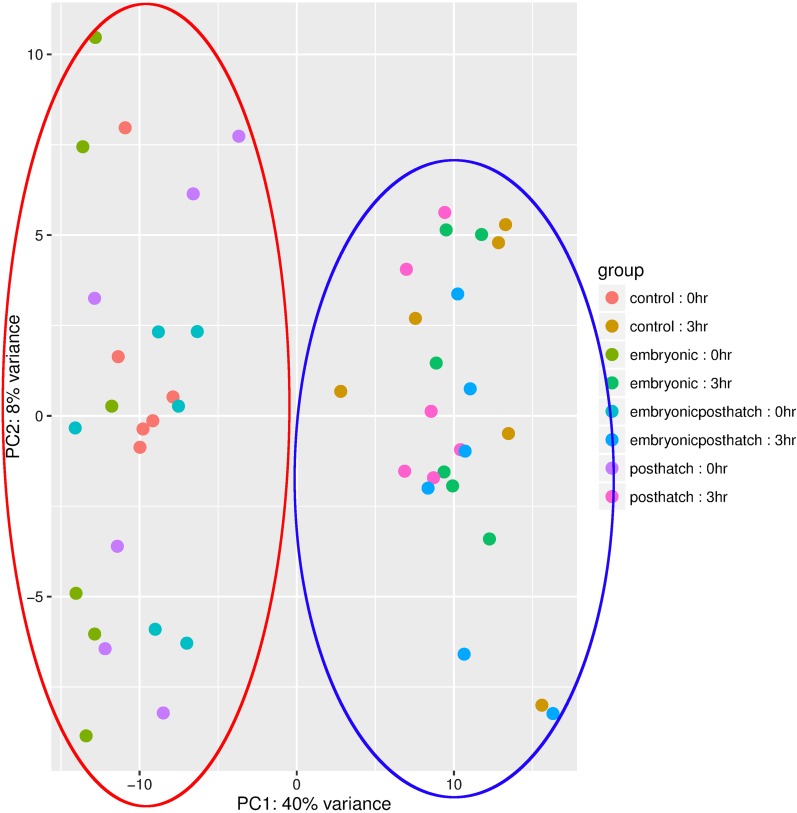
Principle component analysis of treatment vs. time after acute stress. The red circle highlights samples taken at 0 hr and the purple circle highlights samples taken at 3 hr post-stress.